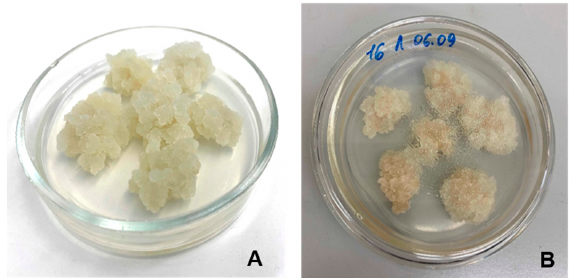
Figure 1. Appearance of the calluses LA14 ( A ) and LA16 ( B ).